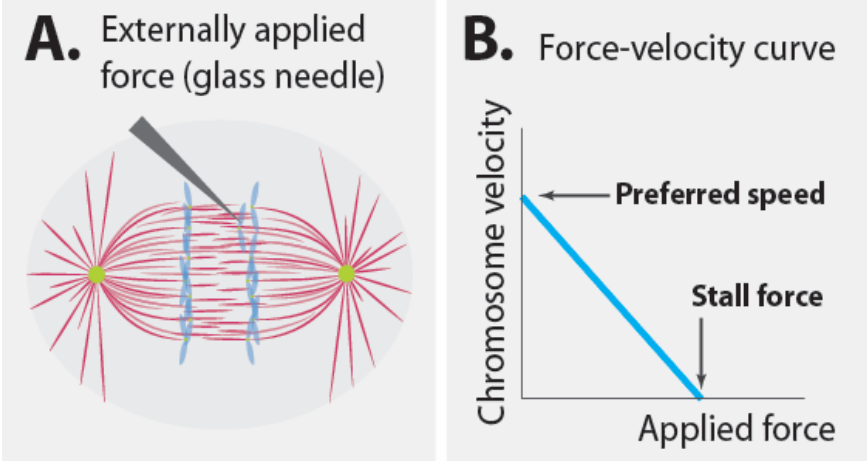
Figure 3. ( A ) Nicklas used a glass needle to apply force on anaphase chromosomes and slowed their motion. ( B ) He characterized the relationship between the applied force and velocity using a force–velocity curve. When no force is applied, the chromosomes move at the spindle’s preferred speed. Since the spindle has a preferred speed, it contains a speed governor. The stall force is the applied force that causes the chromosomes to stop moving. The origin of the speed governor in the spindle remains unclear, and, as will be elaborated on in Section 4, it might not reflect the force-generating properties of the